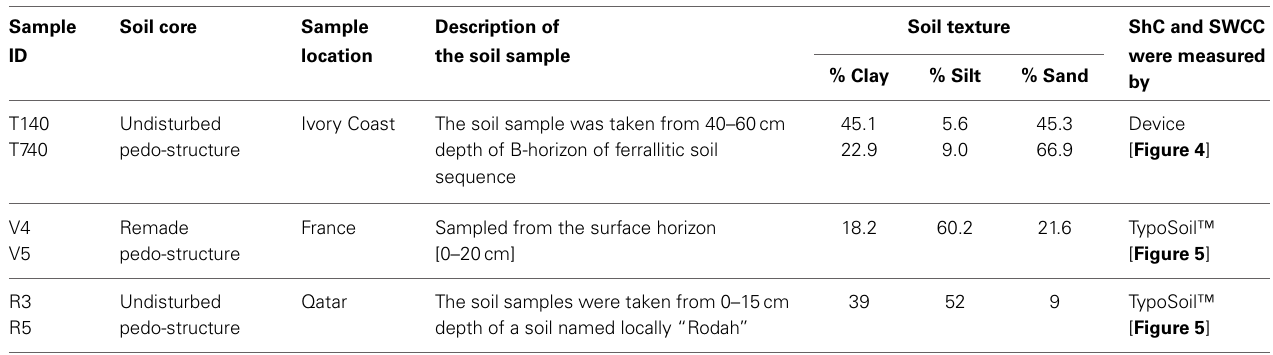
FIGURE 6 | The apparatus TypoSoil™. (A) Schematic drawing for the main components of the apparatus from Braudeau et al. (1999), and (B) Picture of the apparatus while working, one can notice that the apparatus Table 3 | General description of the soil samples used in this